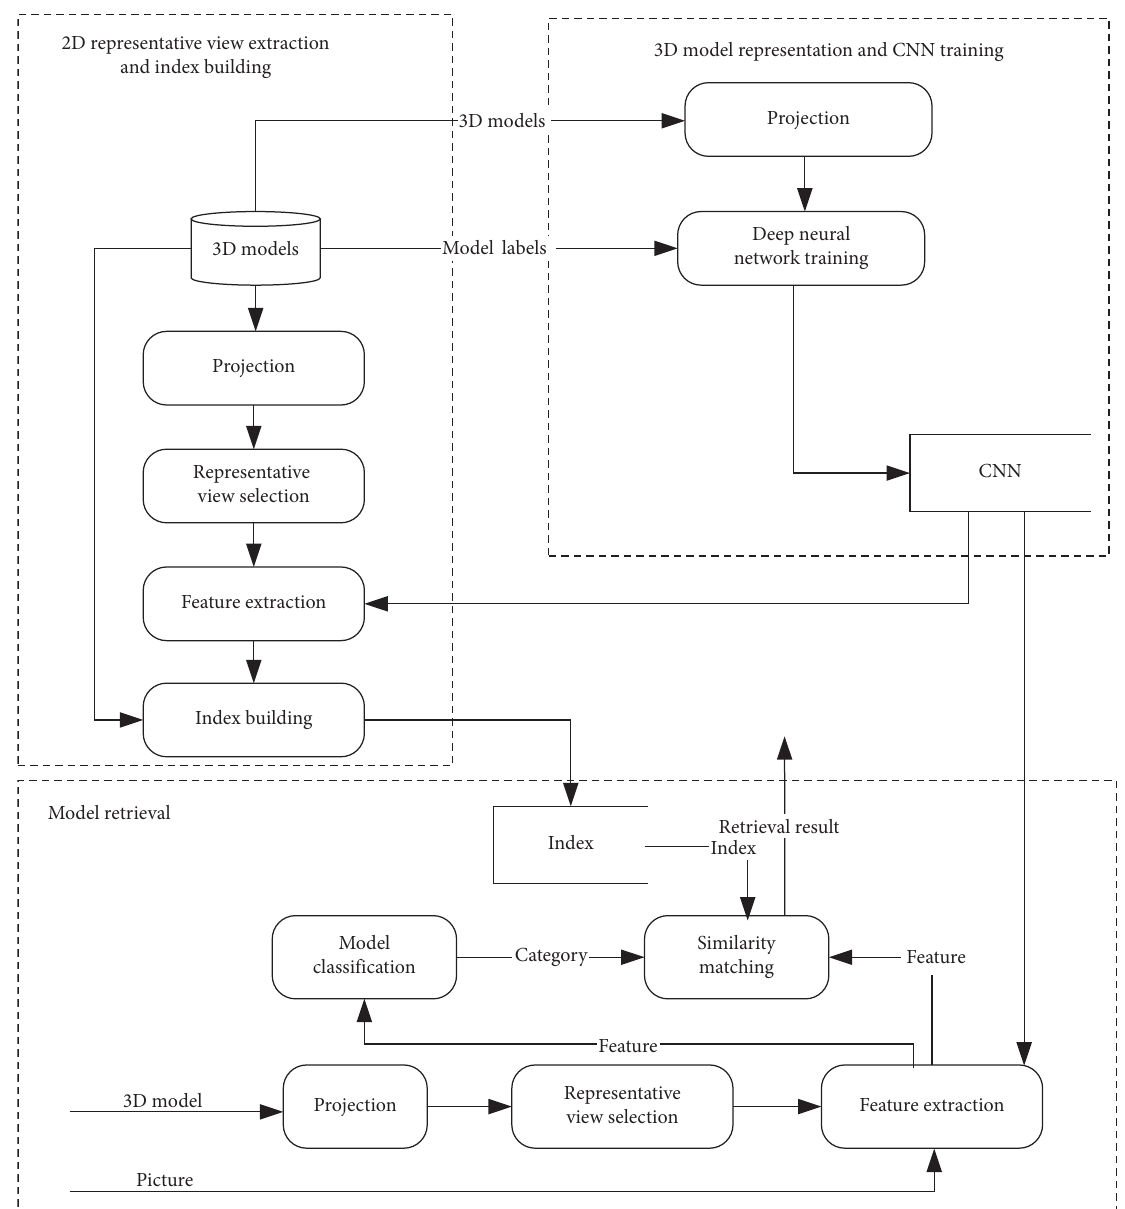
Figure 1: Retrieval